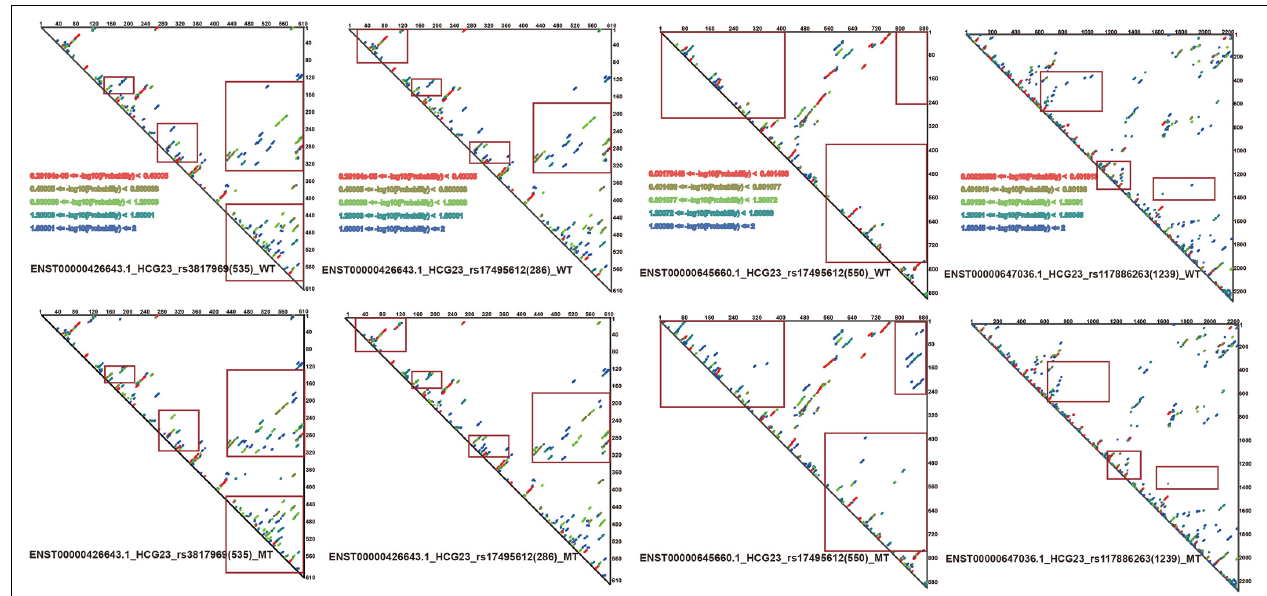
FIGURE 4 | Paired probabilities of WT and MT lncRNA transcripts. Changes in paired probabilities of WT and MT lncRNA transcripts induced by LD SNPs are labeled with red